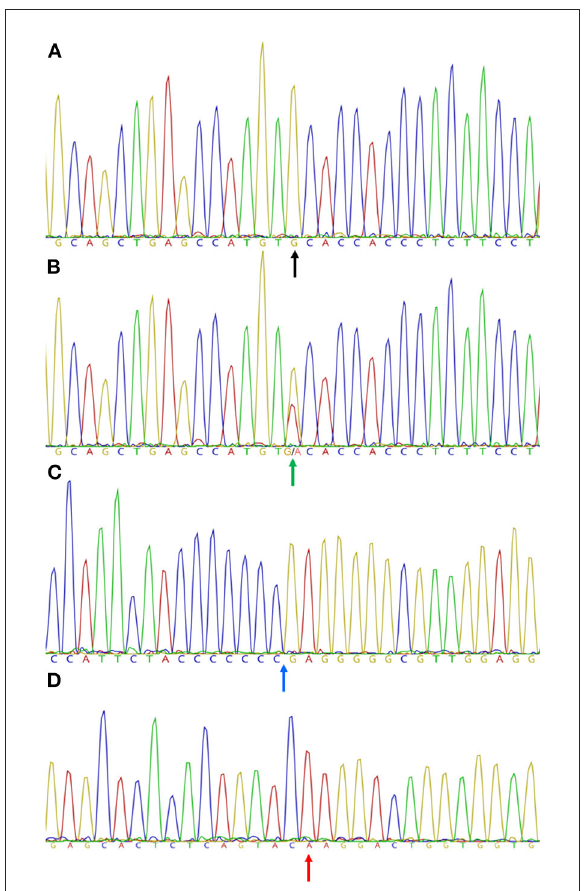
FIGURE1 Partial chromatogram showing capillary sequencing results for homozygous wild-type (A) and heterozygous (B) mutant alleles of the (c.5G > A, PRA-prcd) mutation in the PRCD gene, homozygous wild-type (C) allele of the (c.2601_2602insC; PRA1) mutation in the SLC4A3 gene, and homozygous wild-type (D) allele of the (c.669delA; PRA2) mutation in the TTC8 gene in Golden Retrievers dogs. (A) wild-type allele (guanine) (black arrow); (B) double peak (guanine/adenine) (green arrow); (C) 8th cytosine insertion point (blue arrow); (D) point of an adenine deletion (red arrow). Images were obtained using Geneious ® 10.0 software (Biomatters Ltd., Auckland, New